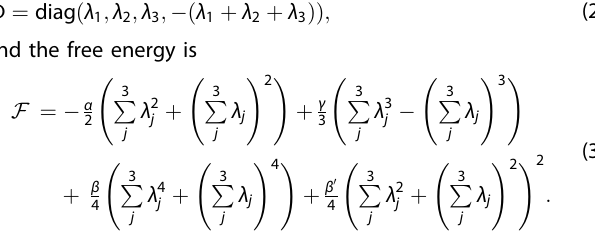
larger than F i = F ii by ( α 2 / β )1/(16 y ) 2 ). Thus, it seems possible that